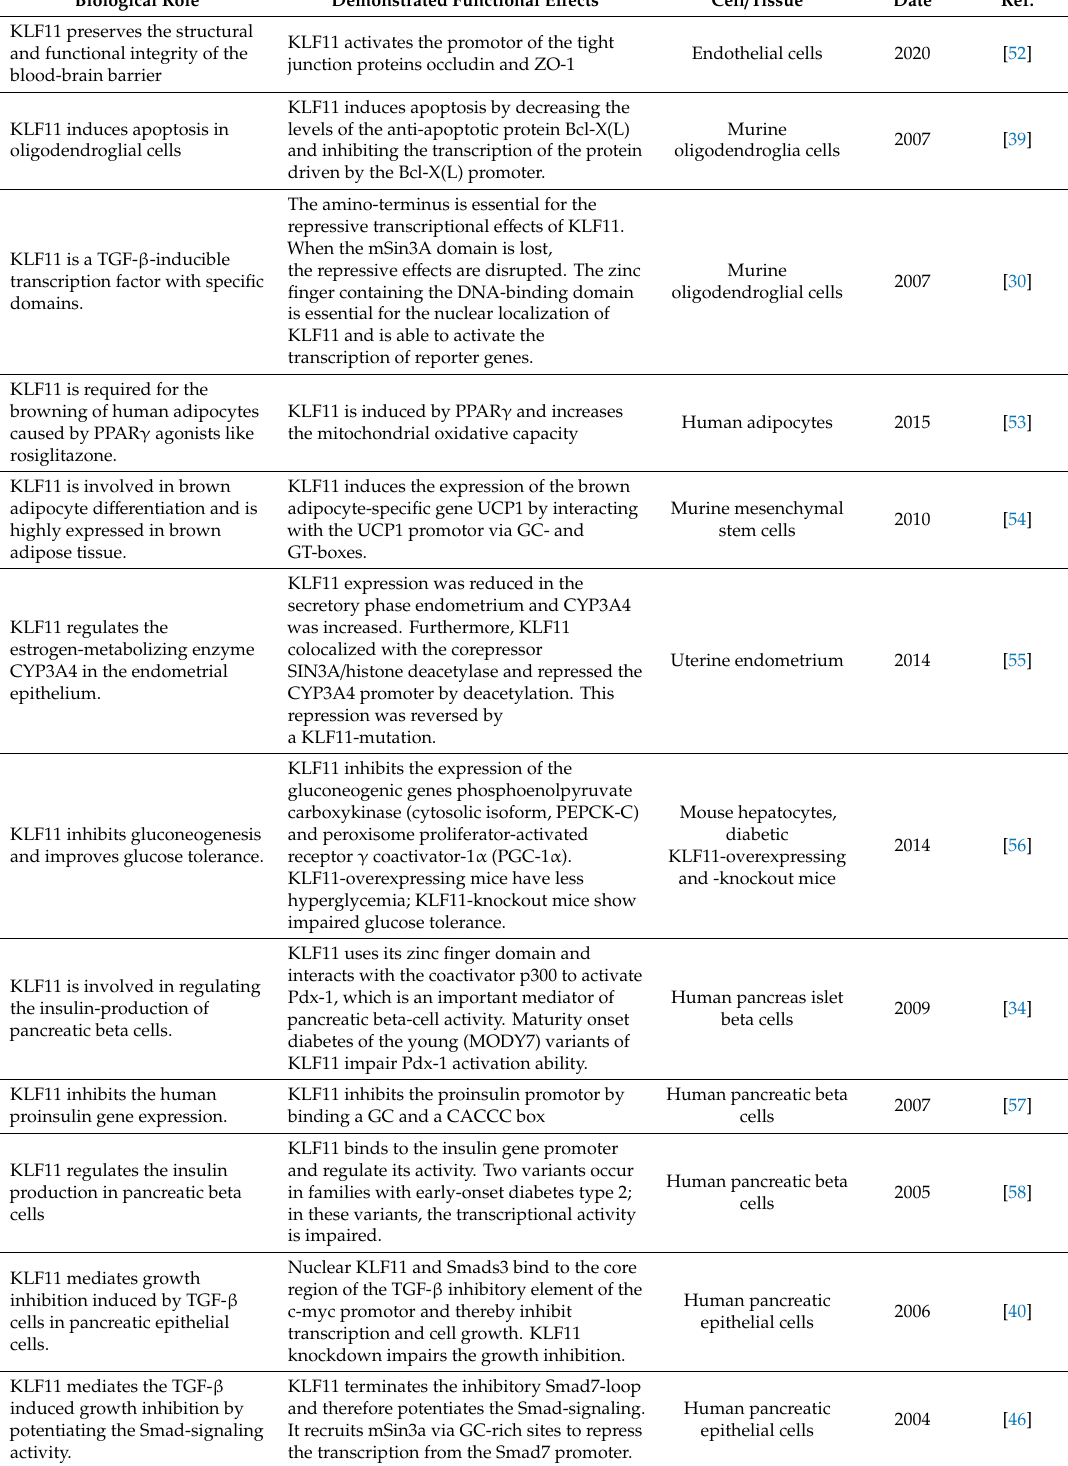
Table 2. KLF11 in normal cells /